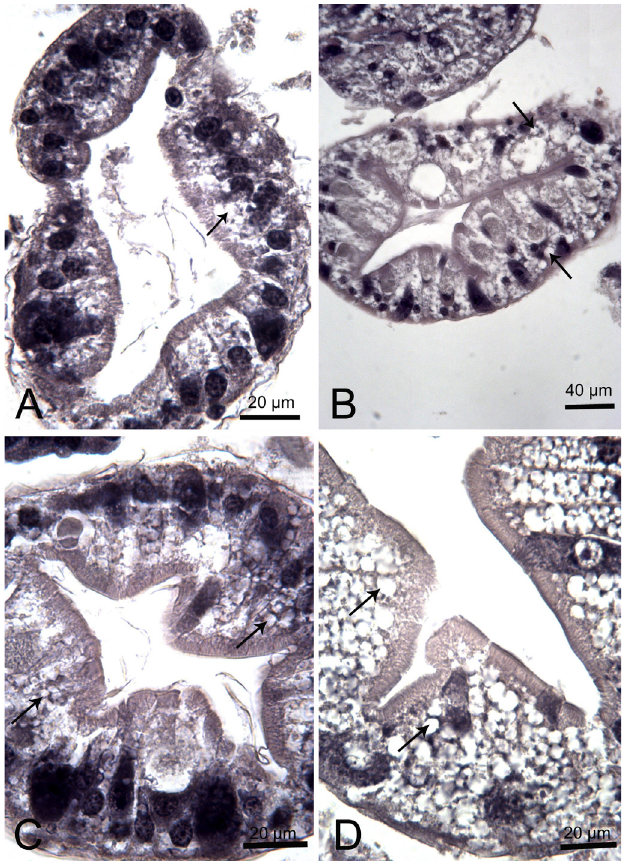
Fig. 3. High magni fi cation images from N. norvegicus digestive gland for lipid droplets density determination. (A) March sampling. Digestive glands tubule from male with a very low density of lipid droplets (arrow). It was scored as 1 at the semi-quantitative scoring system. (B) May sampling. Digestive glands tubule from female with a low-moderate density of lipid droplets (arrow). It was scored as 2 at the semi-quantitative scoring system. (C) May sampling. Digestive glands tubule from male with a moderate-high density of lipid droplets (arrow). It was scored as 3 at the semi-quantitative scoring system. (D) May sampling. Digestive glands tubule from female with a high-very high density of lipid droplets (arrow). It was scored as 4 at the semi-quantitative scoring